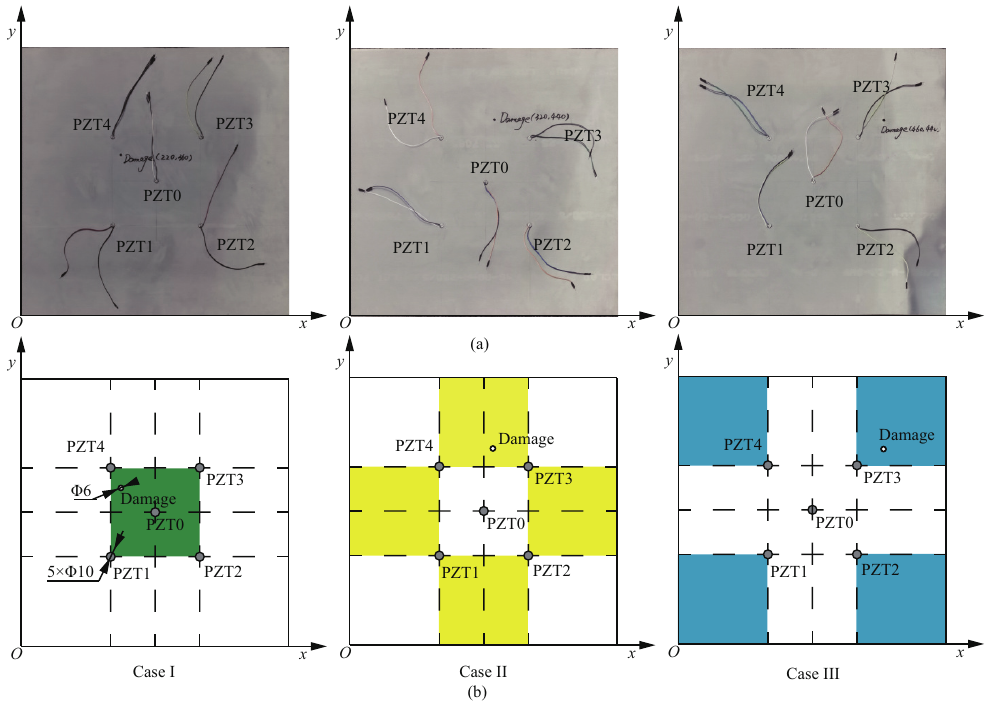
Figure 6. ( a ) Details of specimen, and ( b )